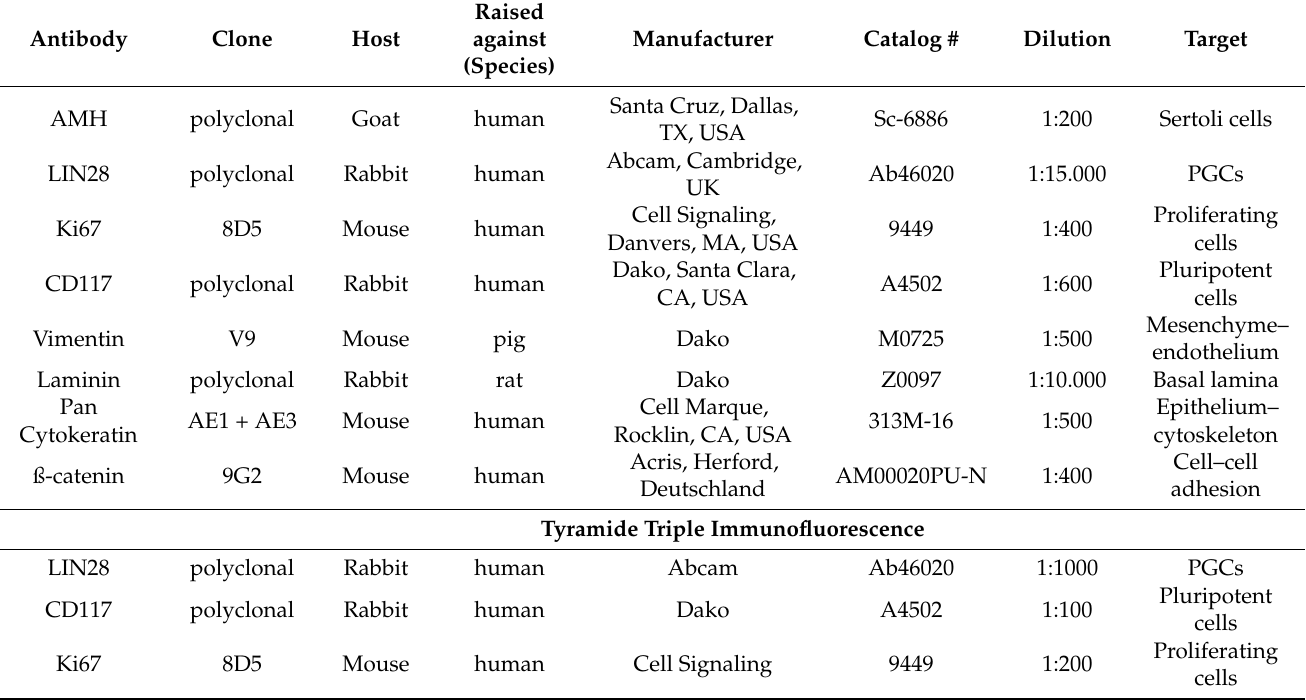
Table 1. List of antibodies used for immunohistochemistry and